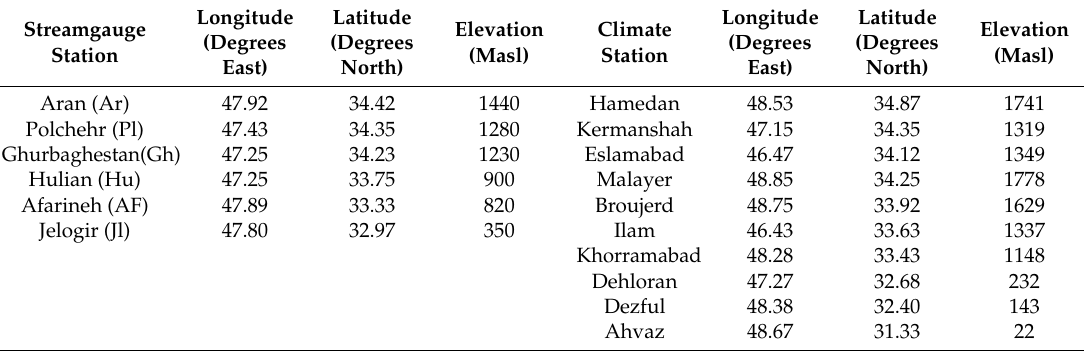
Figure 1. Map of the Karkheh river basin with weather and gauge stations and the Karkheh dam. Geographical characteristics of the flow gauging and climate stations in the KRB are shown in Table 1. The multipurpose Karkheh reservoir, with a designed storage capacity of 7.5 × 10 9 m 3 and net storage capacity of 4.7 × 10 9 m 3 , provides water for irrigation of 320,000 ha of agricultural areas in the lower sections of the KRB, as well as generates 934 GWh hydroelectric power per year and controls flood on the river. Table 1. Geographical characteristics of the selected gauging (left) and climate (right)